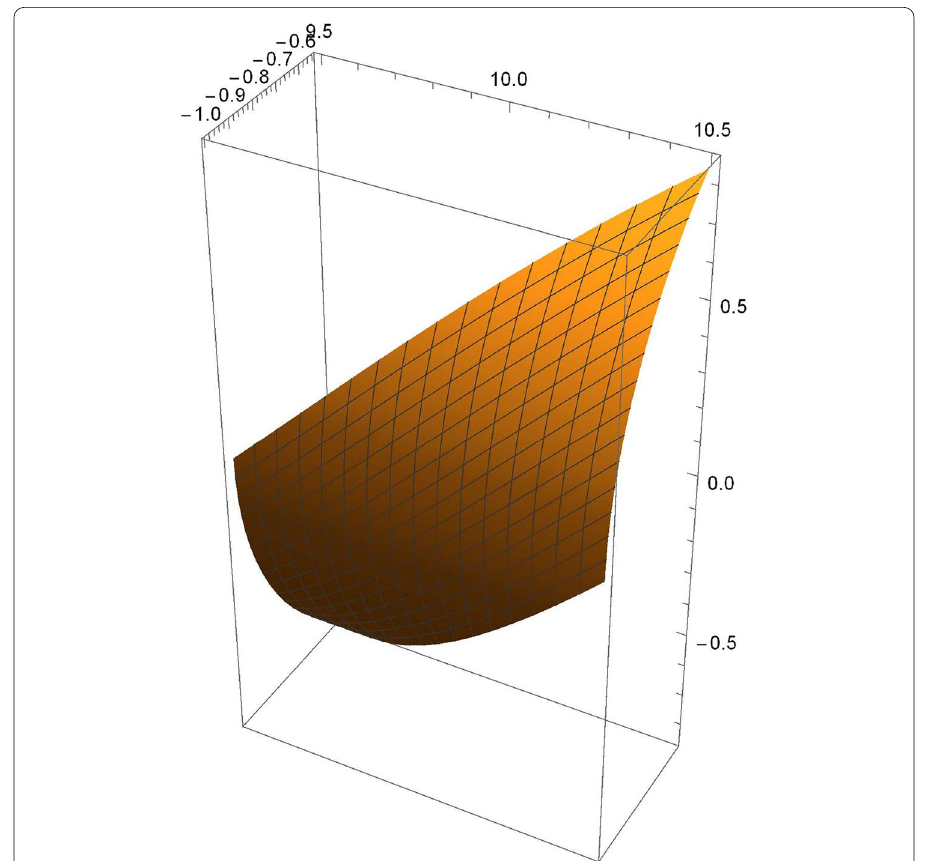
Fig. 1 Hasimoto surface χ( s , t ) = ( s + 10, − cos ( s + t ) ,sin ( s + t